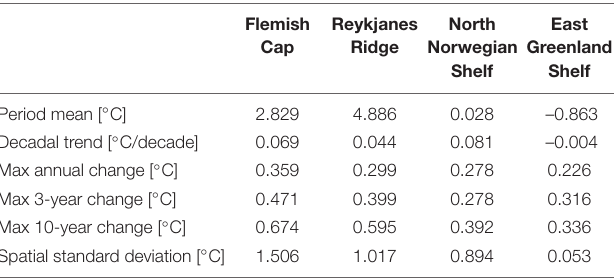
TABLE 5 | Summary of temperature properties at the four sponge habitats areas with bottom deeper than 700 m: Period mean, decadal trend, the maximum change in the monthly mean over a period of 12, 36 months, and 10 years, and the temporal mean of the spatial standard